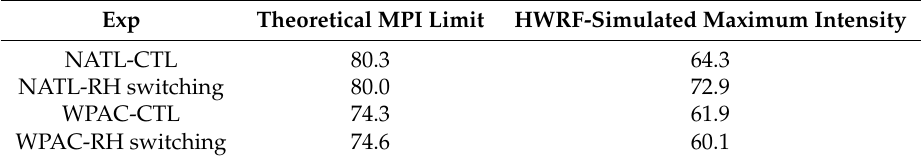
Table 3. Comparison of the theoretical maximum potential intensity (MPI) limit based on Bister and Emanuel (2002)’s calculation and the actual maximum intensity averaged from T = 90 h to T = 120 h obtained from the HWRF model